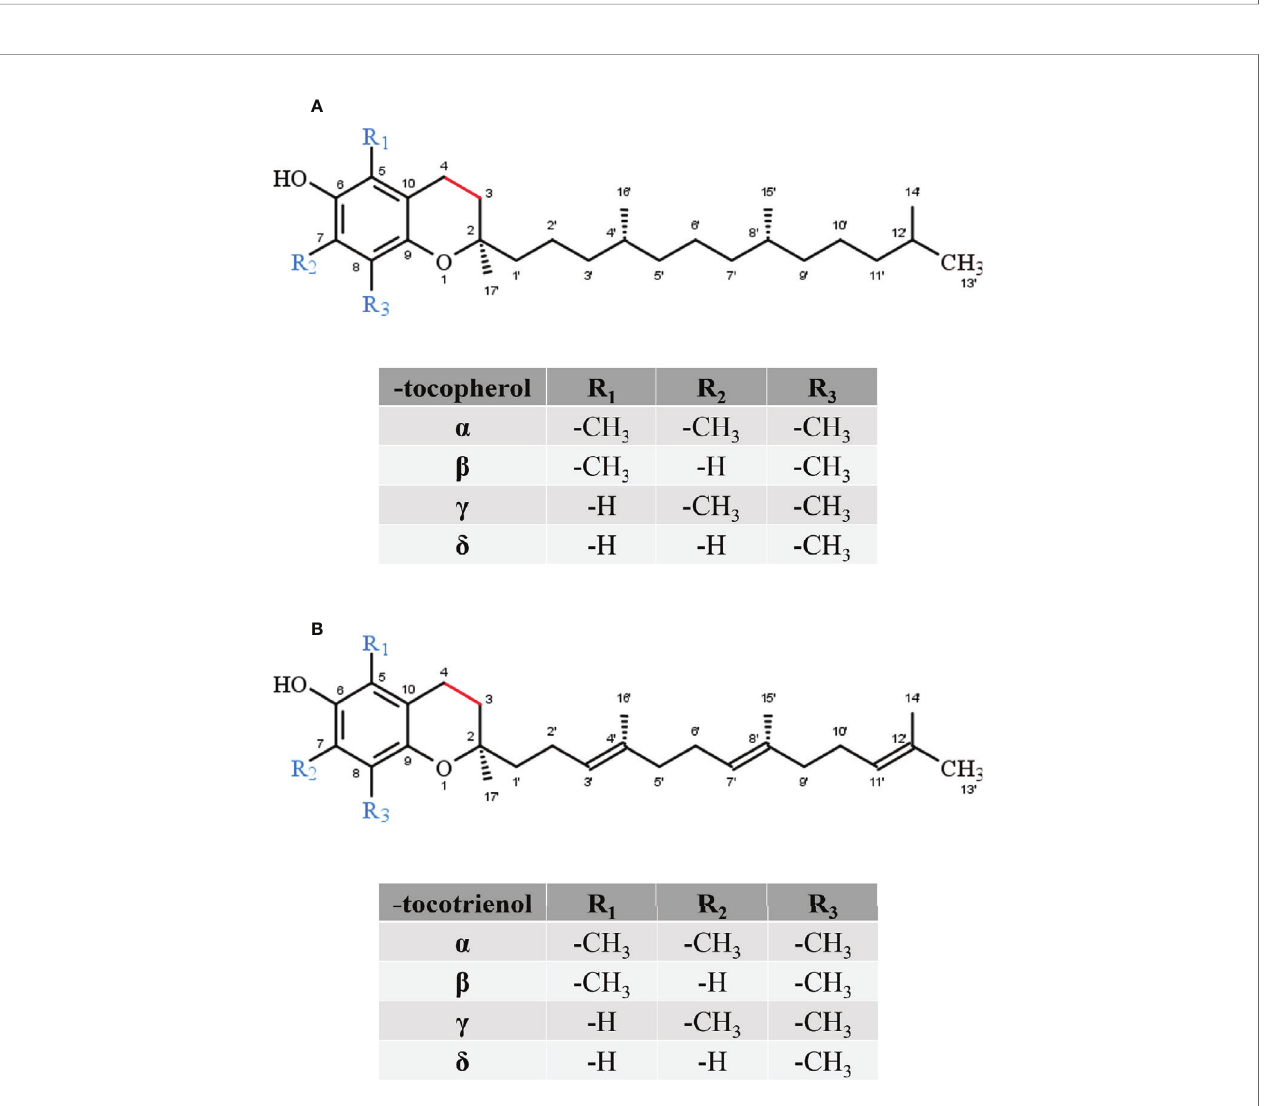
FIGURE 2 | Core structure of (A) tocopherol and (B) tocotrienol